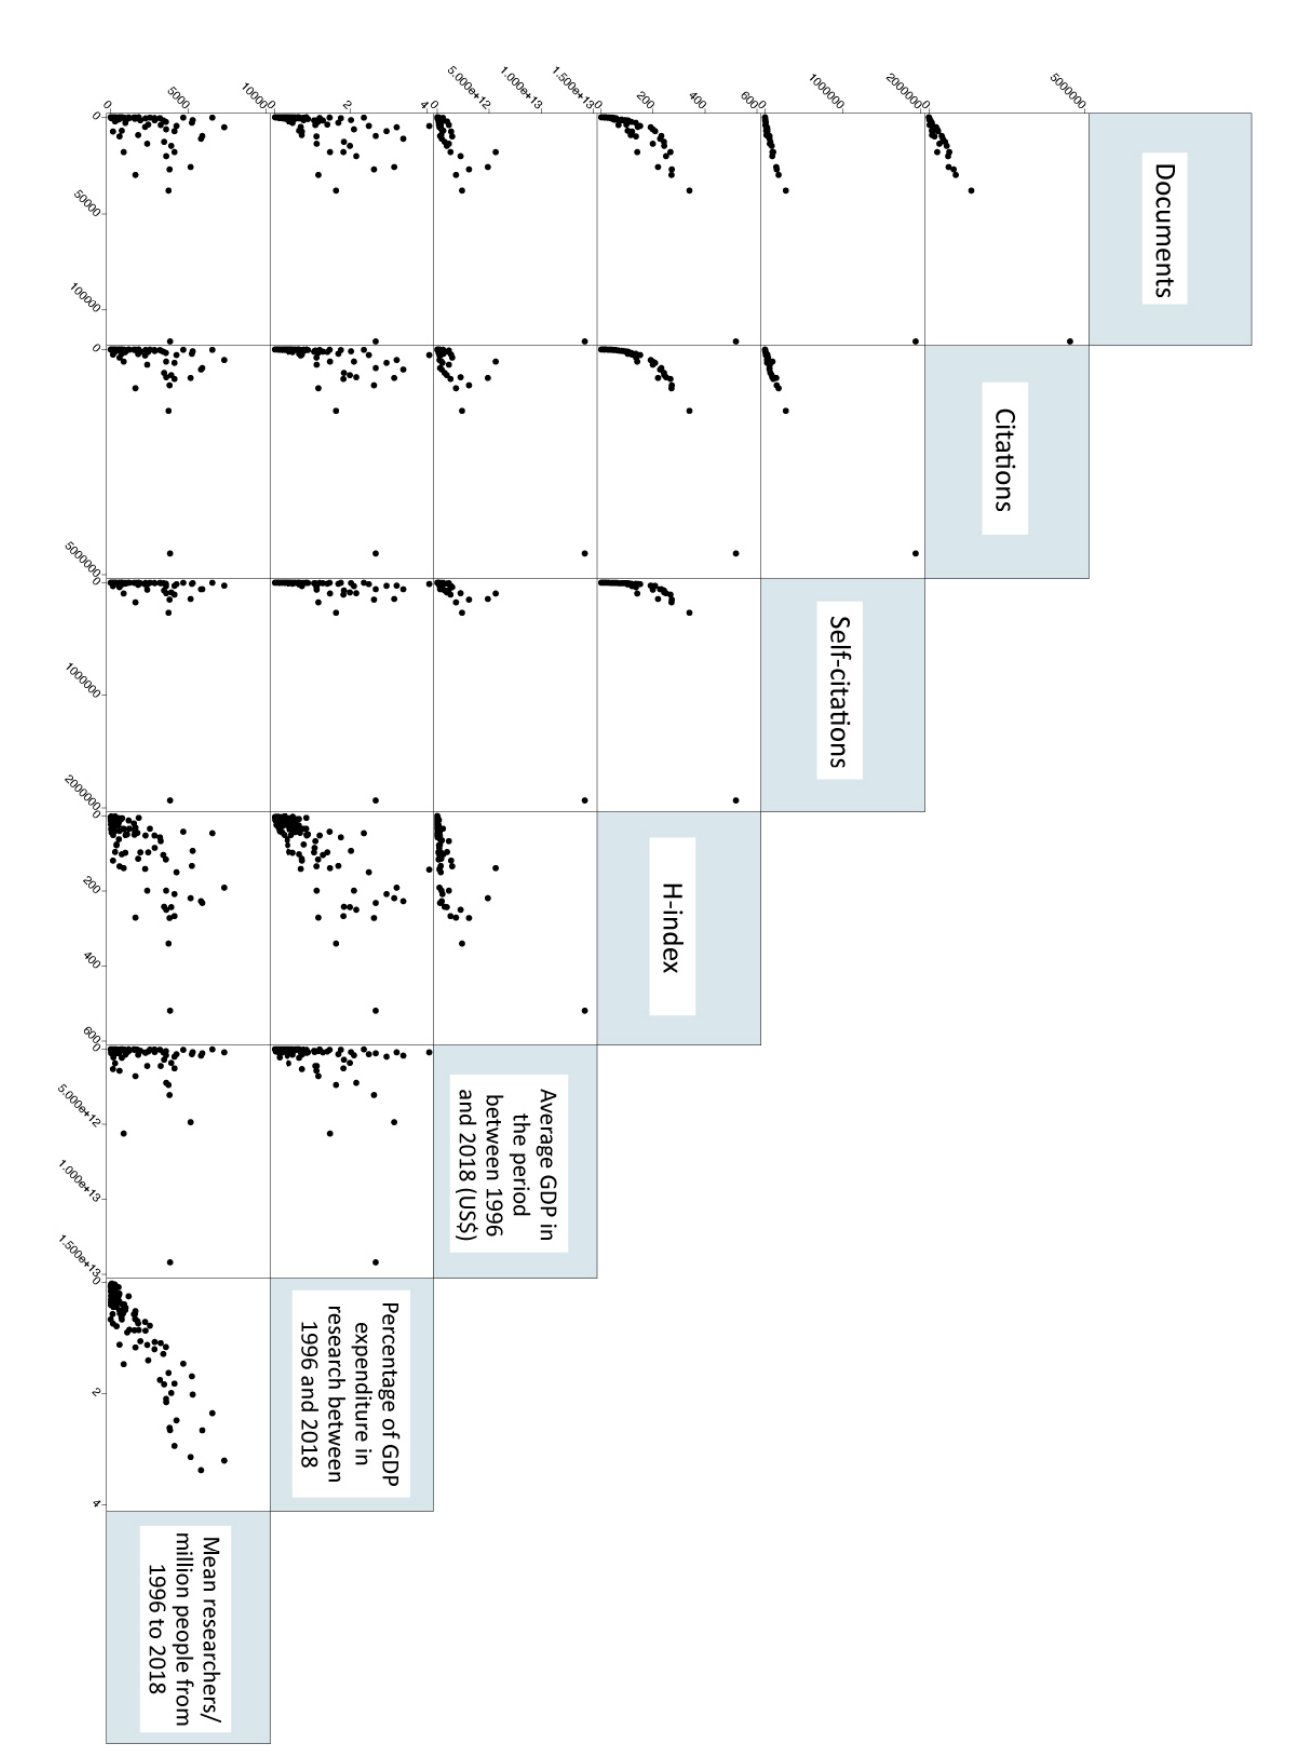
Figure 3. Scatterplot matrices of bibliometric and economic parameters in 173 countries regarding the outputs of endocrinology and diabetes research from 1996 to